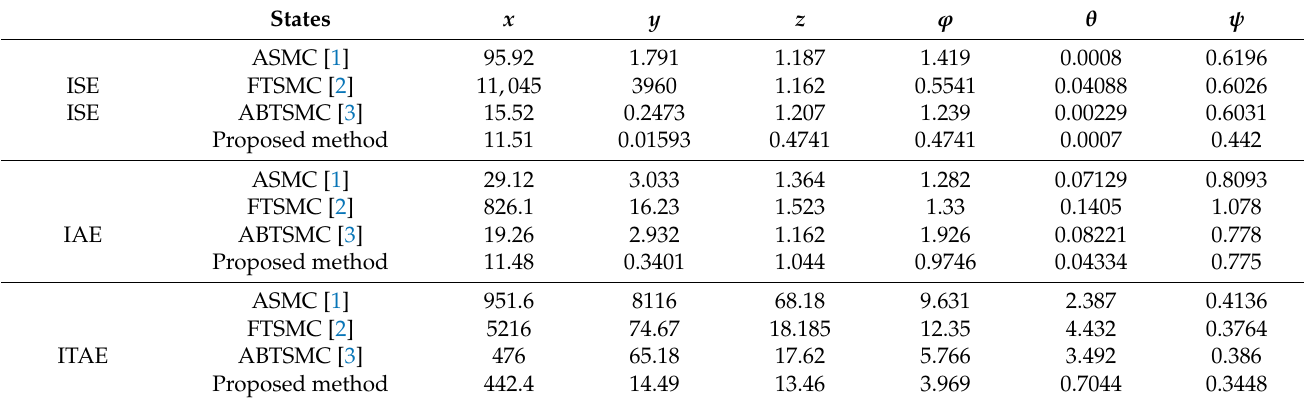
Table 4. Performance indices under 50% step fault in actuators 1 and